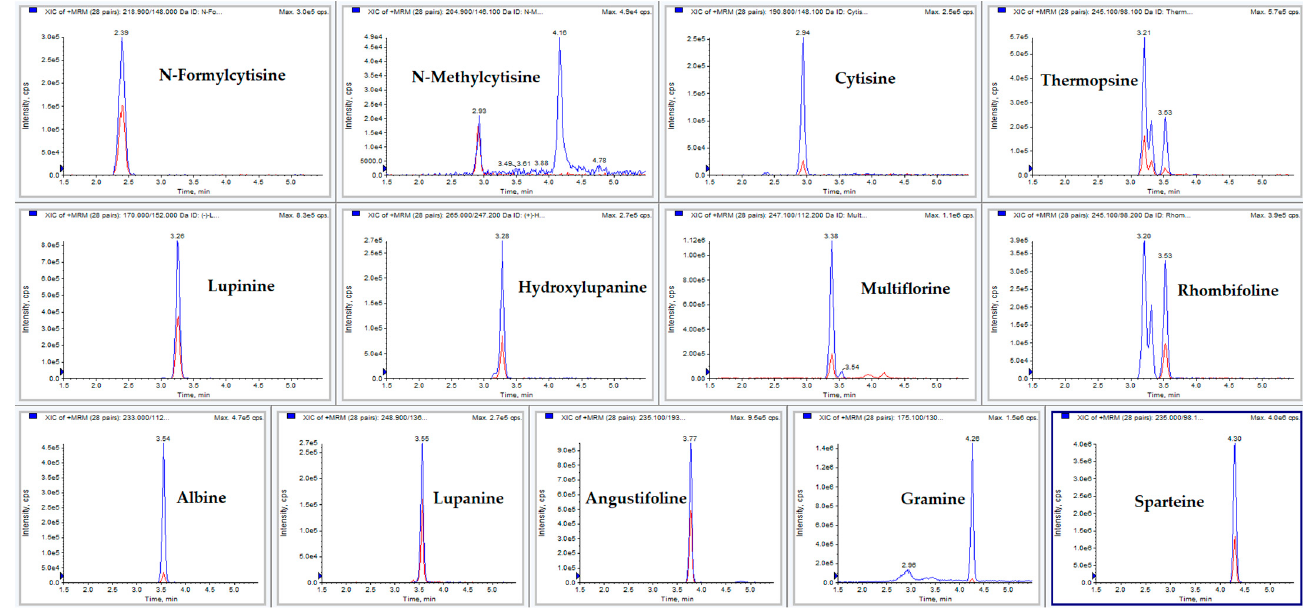
Figure 4. Chromatographic profiles of the selected analytes expressed as extracted ion currents (XICs), obtained by the developed MRM method; in the chromatogram, the chromatographic run of a standard solution at a concentration of 20 ng mL − 1 is shown.